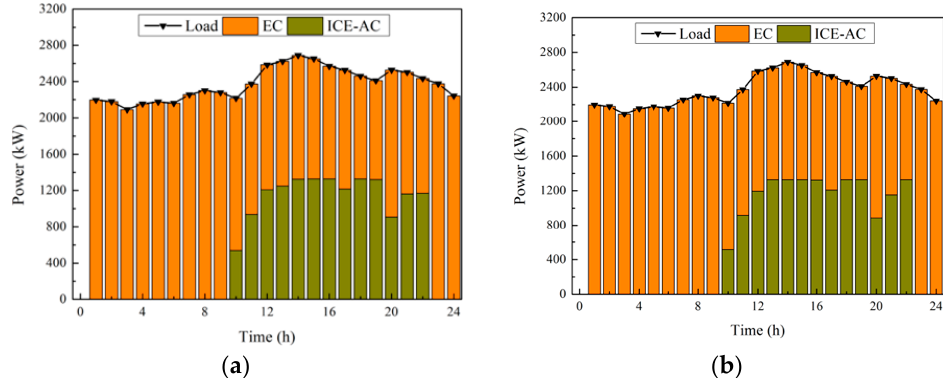
Figure 12. Operational power of heat in summer: ( a ) without considering off-design characteristics; ( b ) considering off-design characteristics.